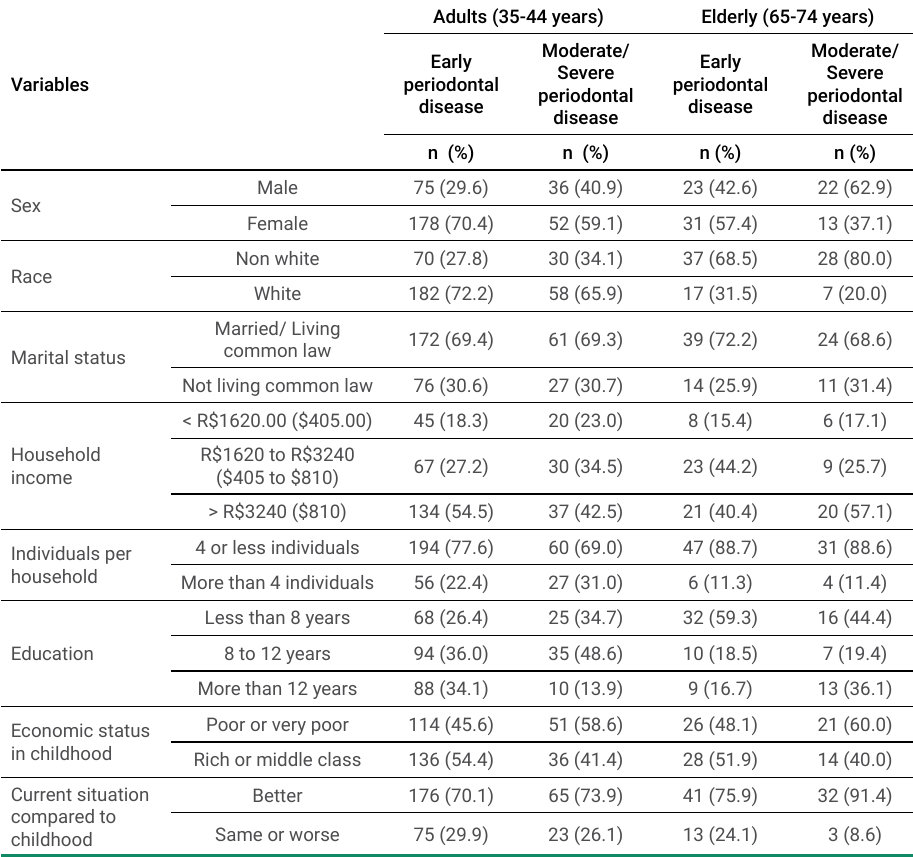
Table 1. Distribution of periodontal conditions according to demographic and socioeconomic factors in adult and elderly populations from Jundiaí City.